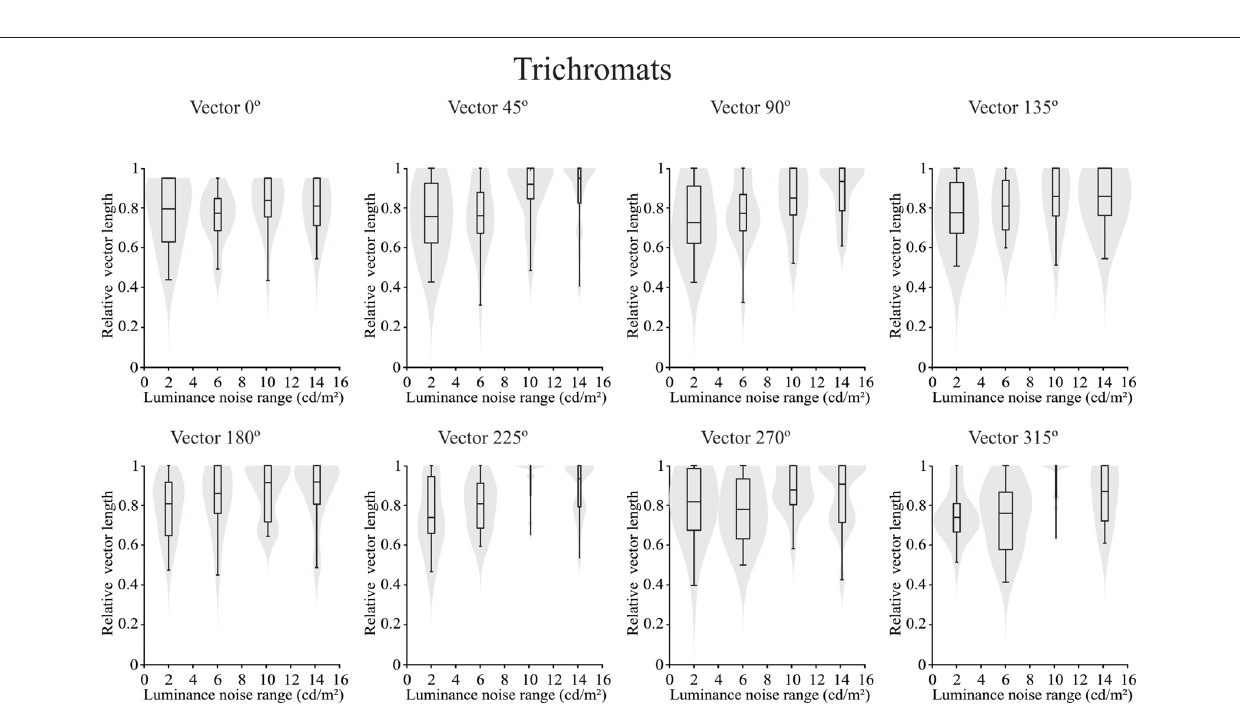
FIGURE 5 | Violin plots of chromatic thresholds estimated from trichromats as a function of the luminance noise amplitude at each chromatic vector. No difference was found in the multiple comparisons from trichromats data. Shaded gray areas are the kernel density plot that represents 95% of the data distribution, and the box plot comprises horizontal lines that represent third quartile (upper line), median (middle line), first quartile (lower line) and whiskers represents the maximum and minimum